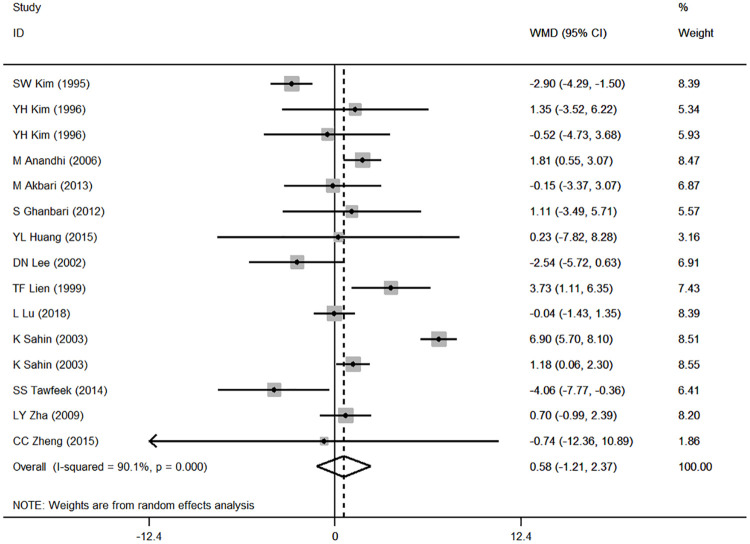
Forest plot of ADG.